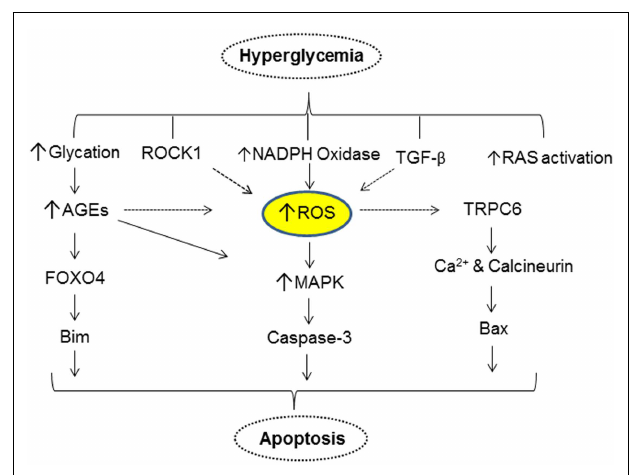
FIGURE 2 |A simplified scheme that describes hyperglycemia mediated alterations in various cellular events resulting in apoptosis of podocytes